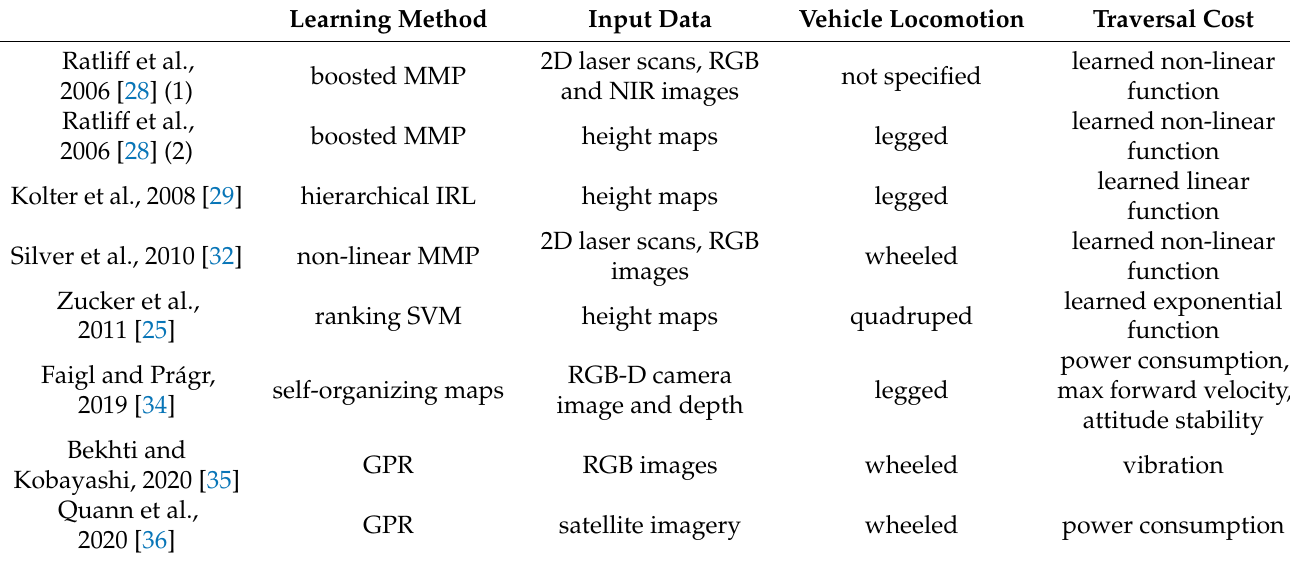
Table 1. Works on regression of traversal costs with classical machine